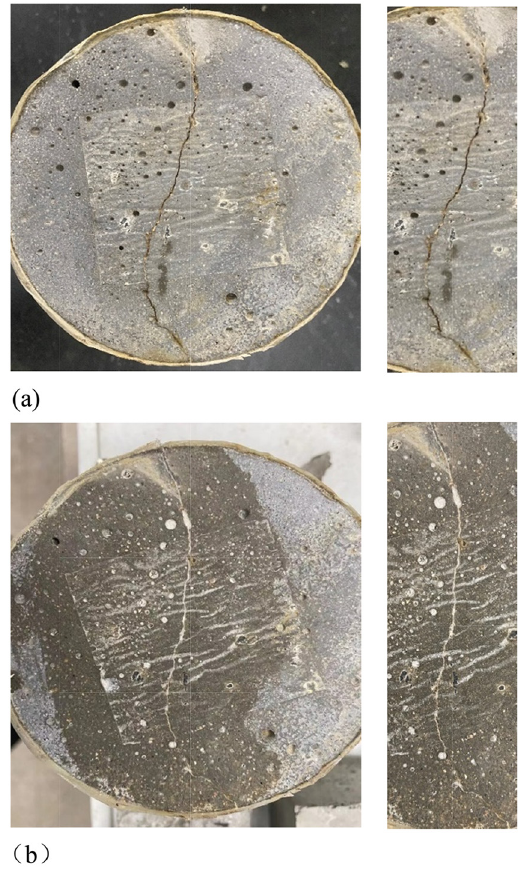
Figure 5: The repair e ff ect of the crack surface: ( a ) initial crack and ( b ) cracks after